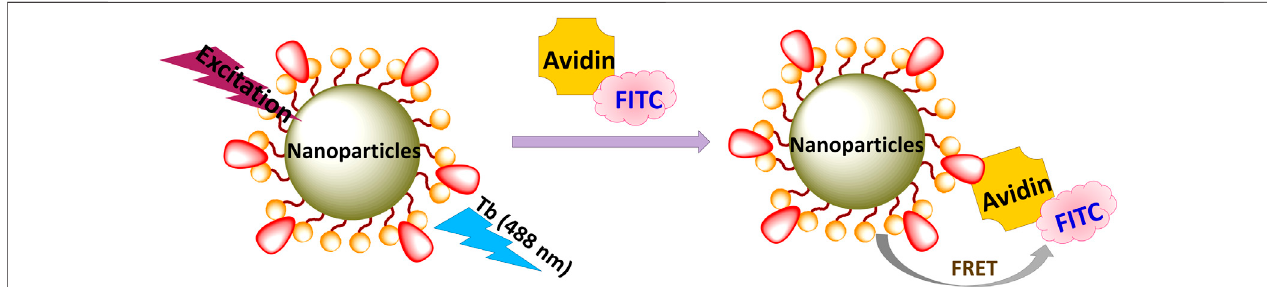
FIGURE 14 | Schematic illustration of FRET detection of